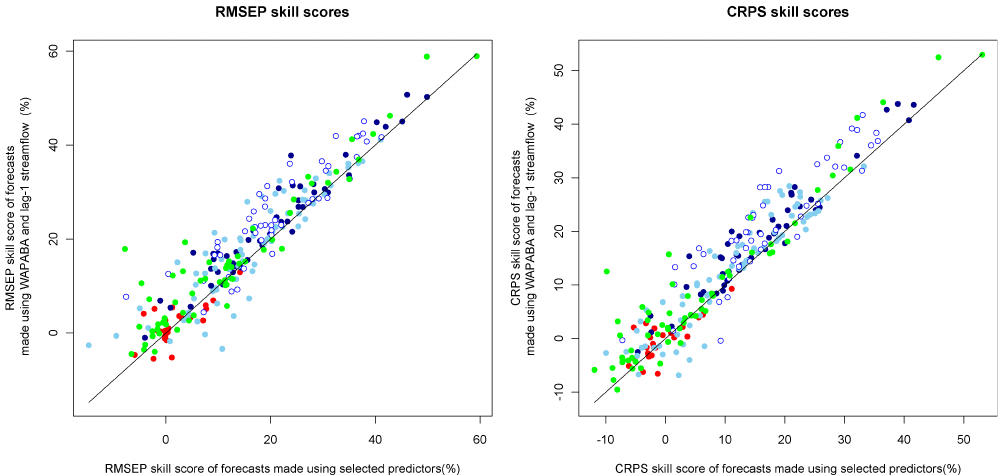
Fig. 3. Skill scores of forecasts made using WAPABA simulations and lag-1 streamflow as predictors plotted against skill scores of forecasts made using selected predictors for the RMSEP (left panel) and CRPS (right panel) skill scores. Each point represents the skill of forecasts for a single location and season. Points above the 1:1 line indicate improvements in forecast skill. (Green points are catchments in Queensland, red points are catchments in Tasmania, hollow blue circles tributaries to the upper Murray River, light blue are catchments in central Victoria and dark blue are catchments in southern Victoria).